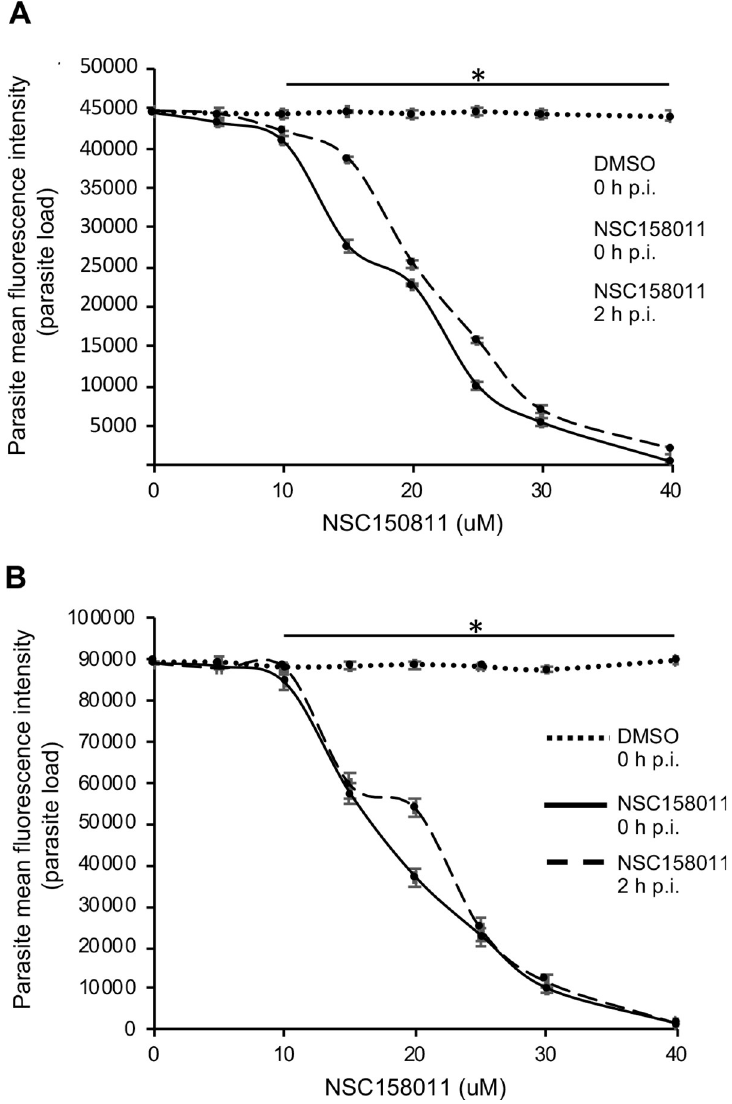
Fig 4. Analysis of the effect of varying concentrations of compound NSC158011 on the growth of Cryptosporidium parvum in HCT-8 cells. Equal amounts of freshly excysted sporozoites of C . parvum were inoculated into HCT-8 cells in culture and varying concentrations of NSC158011 added at the time of infection (solid line) or added 2 h post-infection (p.i.) (dashed line). Control infected cells (dotted line) were treated immediately p.i. with volumes of DMSO equivalent to those used in the compound-treated cultures. The cells were analyzed for parasite infectivity and proliferation by an immunofluorescence assay after (A) 48 h, and (B) 72 h of culture. The fluorescence generated by intracellular C . parvum merozoites was quantified and is shown on the Y -axis representing the parasite load. The data shown represent means of three independent experiments with standard error bars and levels of statistical significance between groups indicated by asterisk ( � , P < 0.05).